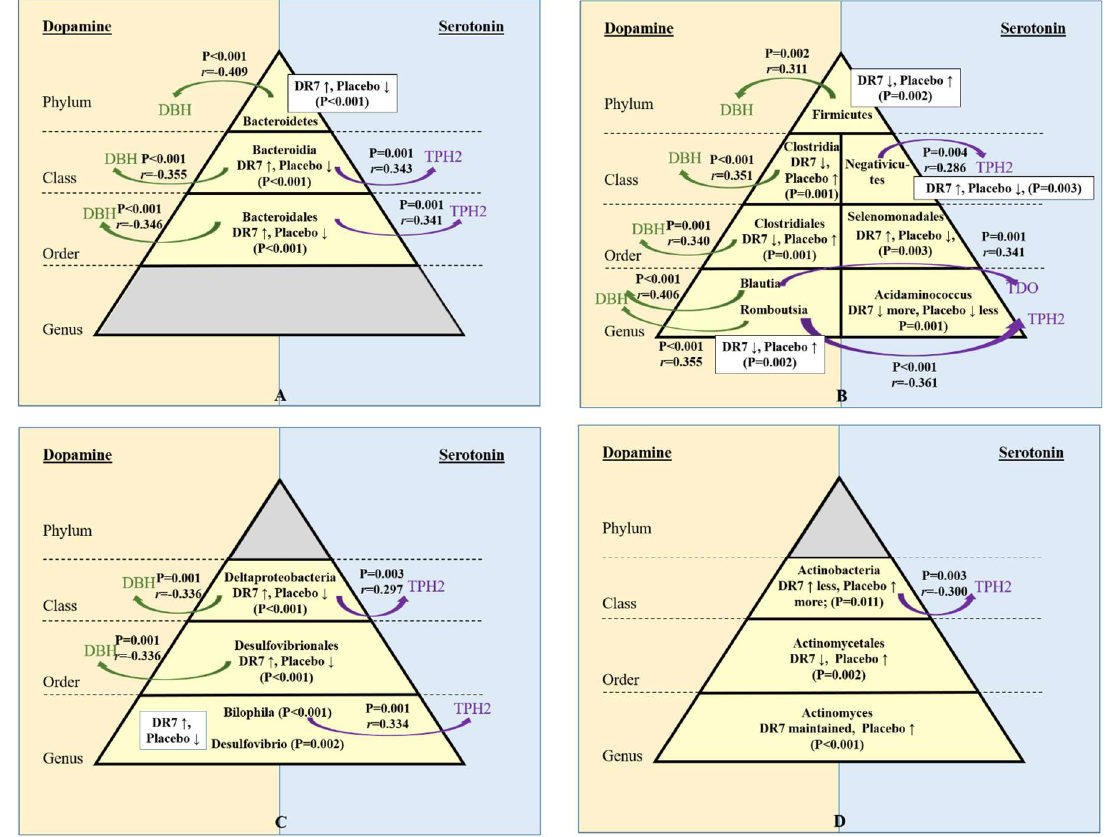
Figure 5. Changes in gut microbiota after 12-week administration of Lactobacillus plantarum DR7 compared to placebo group along the lineage of phylum Bacteroidetes ( A ) and Firmicutes ( B ) and classes Deltaproteobacteria ( C ) and Actinobacteria ( D ). Only microbiota groups which showed significant changes over 12 weeks between placebo and DR7 groups are shown (as indicated by p -values inside the pyramid; Mann–Whitney U test; ↑ indicates an increase over 12 week and ↓ indicates a reduction over 12 weeks). Curved arrows indicate correlations between gut microbiota and blood gene expressions of dopamine β -hydroxylase (DBH), tryptophan hydroxylase-2 (TPH2), and tryptophan 2,3-dioxygenase (TDO) ( p -value and rho ( r ) obtained from Spearman’s rank correlations. n = 99 for gut microbiota (DR7 n = 55 and placebo n = 44); n = 111 for blood gene expressions (DR7 n = 56 and placebo n = 55).